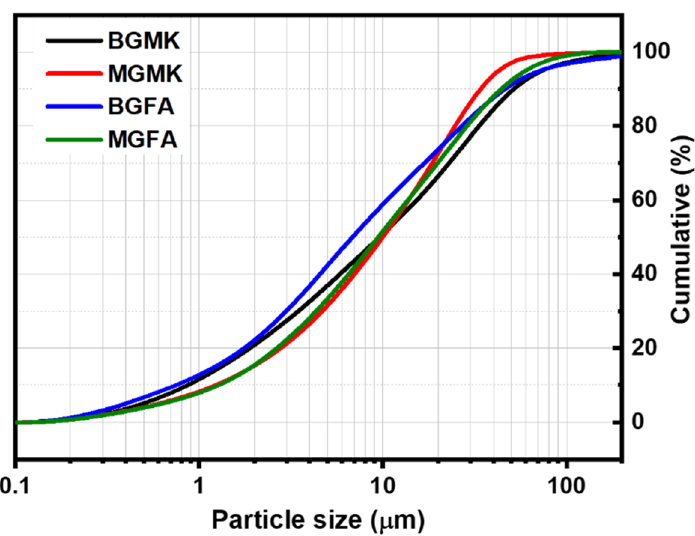
Figure 8. Particle size distribution curves for the ball-milled geopolymer wastes.